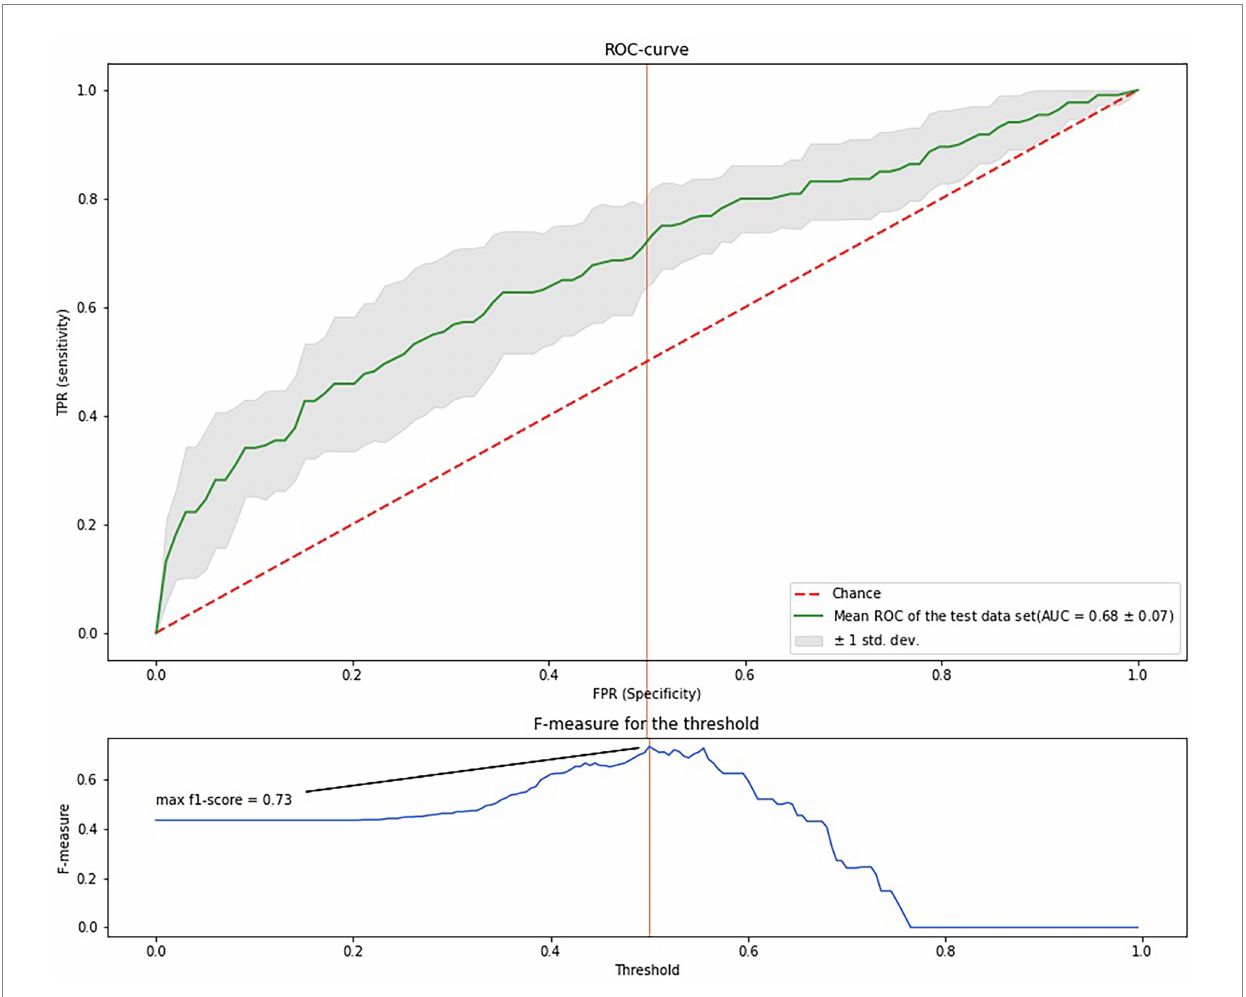
FIGURE 3 ROC-curve of the predictive model based on the randomized forest algorithm.